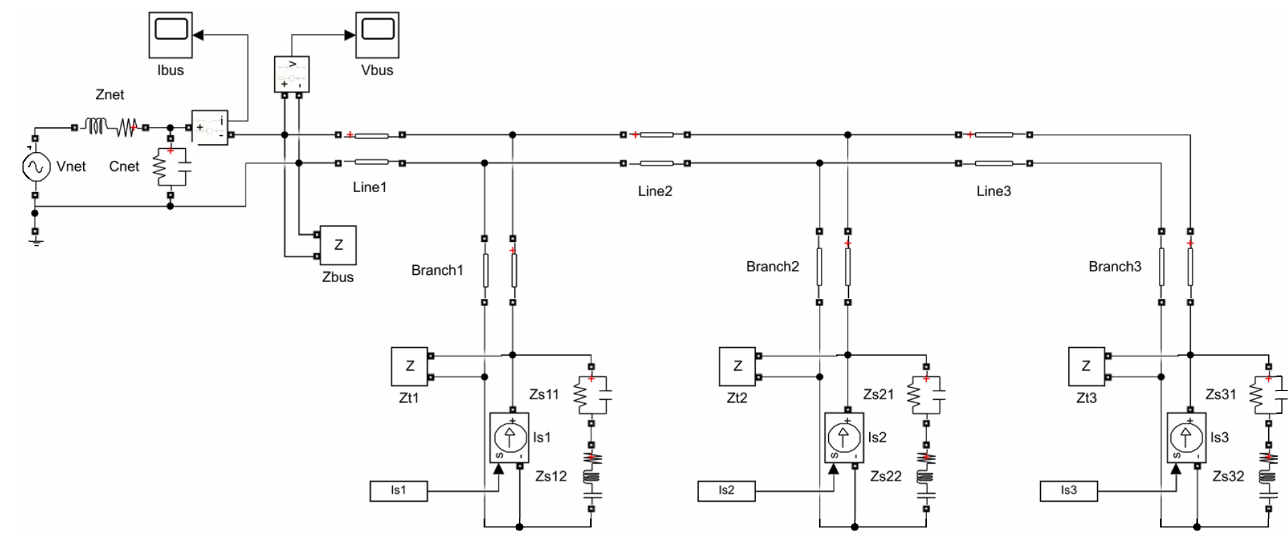
Figure 6. Example of Simulink Simscape model for a 3-block DC